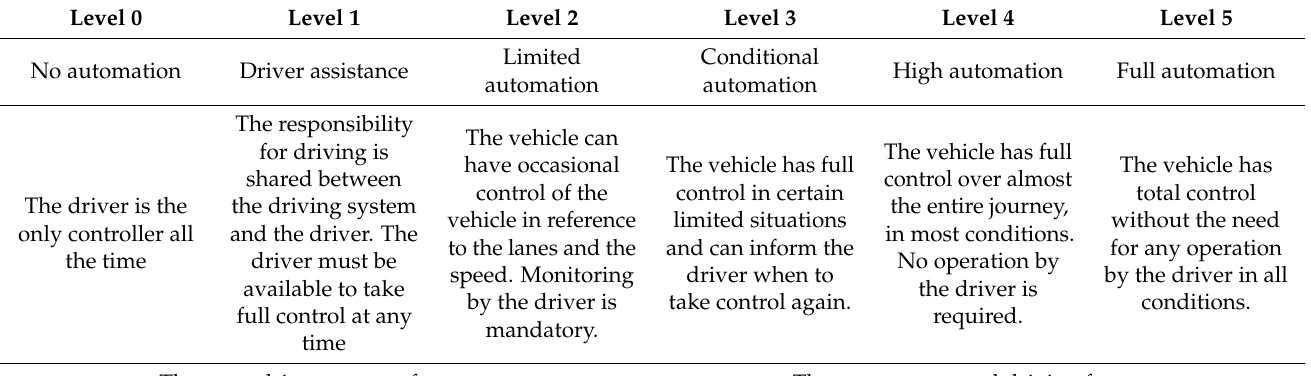
Table 1. Levels of driving automation Society of Automotive Engineers (SAE)